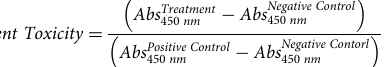
h prior to infection. Bacteria were washed thrice with PBS, optical density at 600nm measured, and diluted to a multiplicity of infection (MOI) of 10 in Dulbecco PBS (DPBS). MOI is calculated based on an established optical density and colony forming unit (CFU) calibration, and the number of mammalian cells per well at the time of infection approximated based on their 24-h doubling time. Mammalian cells were washed thrice with Dulbecco ’ s phosphate-buffered saline (DPBS, Fisher Scienti fi c) prior to addition of DPBS containing bacteria for a 45-min infection at HeLa growth conditions. After infection media was replaced with HeLa full growth media con- taining 100µg/mL gentamicin instead of P/S to remove any extracellular bacteria and incubated for 75min before replacement with full cell culture media containing 10µg/ mL gentamicin instead of P/S and respective treatment and incubated for 18h. Following 18 h treatment, wells for CFU analysis were washed thrice with 300